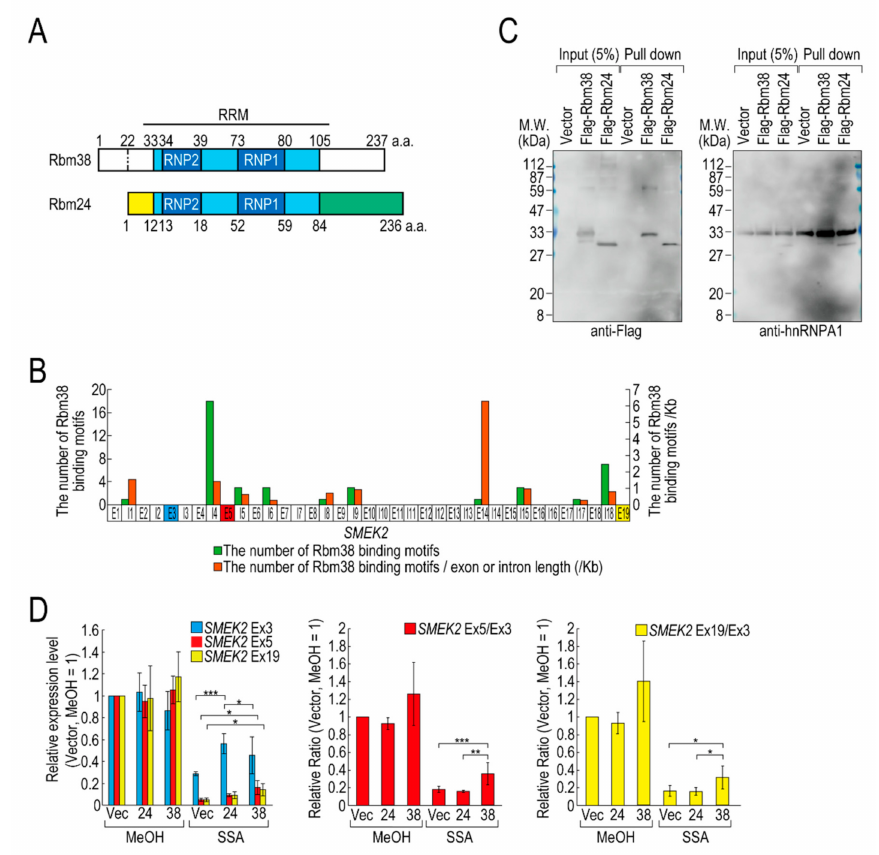
Figure 2. Rbm38, but not Rbm24, suppresses the transcription elongation defect caused by splicing deficiency. ( A ) A schematic of the structure of the indicated RNA binding proteins. ( B ) The distribution of Rbm38 binding motifs in the SMEK2 gene. The number of Rbm38 binding sites listed in Table S2 was counted. ( C ) Flag-Rbm38 and Flag-Rbm24 were expressed in HEK293T cells and the biotinylated substrate RNA was prepared by in vitro transcription from an SMEK2 plasmid containing intron 4. The substrate RNA was purified using streptavidin beads and co-precipitated proteins were analysed by Western blotting. ( D ) HeLa cells were transfected with a vector (Vec), and Flag-Rbm24 (24) and Flag-Rbm38 (38) plasmids. The transfected cells were treated with SSA and 5-EU, and the labeled RNA was analysed as in Figure 1. Error bars indicate S.D. ( n = 3). Statistical significance was investigated by one-way ANOVA and Tukey’s test (*: p < 0.05; **: p < 0.01; ***: p <